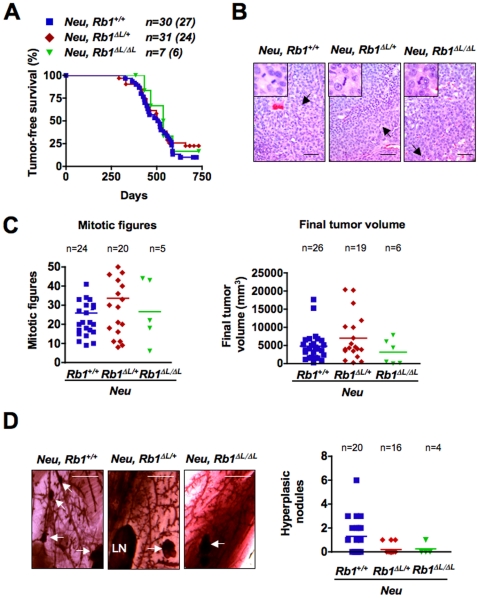
Loss of pRB-LXCXE interactions does not affect Neu-driven tumorigenesis.A) Onset of mammary tumorigenesis is shown for the indicated genotypes (log rank test; P = 0.6788). Values in brackets indicate the number of mice that developed tumors. B) Representative H&E stained paraffin sections from tumors harvested from Neu; Rb1+/+, Neu; Rb1ΔL/+, and Neu; Rb1ΔL/ΔL mice 60 days after initial tumor palpation. Arrows indicate mitotic figures that are shown in the inset. Scale: 50 µm. C) The mitotic index and final tumor volumes for Neu; Rb1+/+, Neu; Rb1ΔL/+, and Neu; Rb1ΔL/ΔL mice are indicated, along with the average values for each genotype. Mitotic indices were derived by quantifying the number of mitotic figures in five random fields of view for each mouse. Final tumor volume was calculated using the formula V = 0.52×W2×L. D) Carmine Red–stained mammary whole mounts from tumor-free glands in mice that had mammary tumors are shown for the given genotypes. Arrows indicate hyperplastic nodules and LN indicates lymph nodes. Scale: 2 mm. The number of hyperplastic nodules in each whole mount section was also quantified for each genotype along with the average number of hyperplastic nodules.